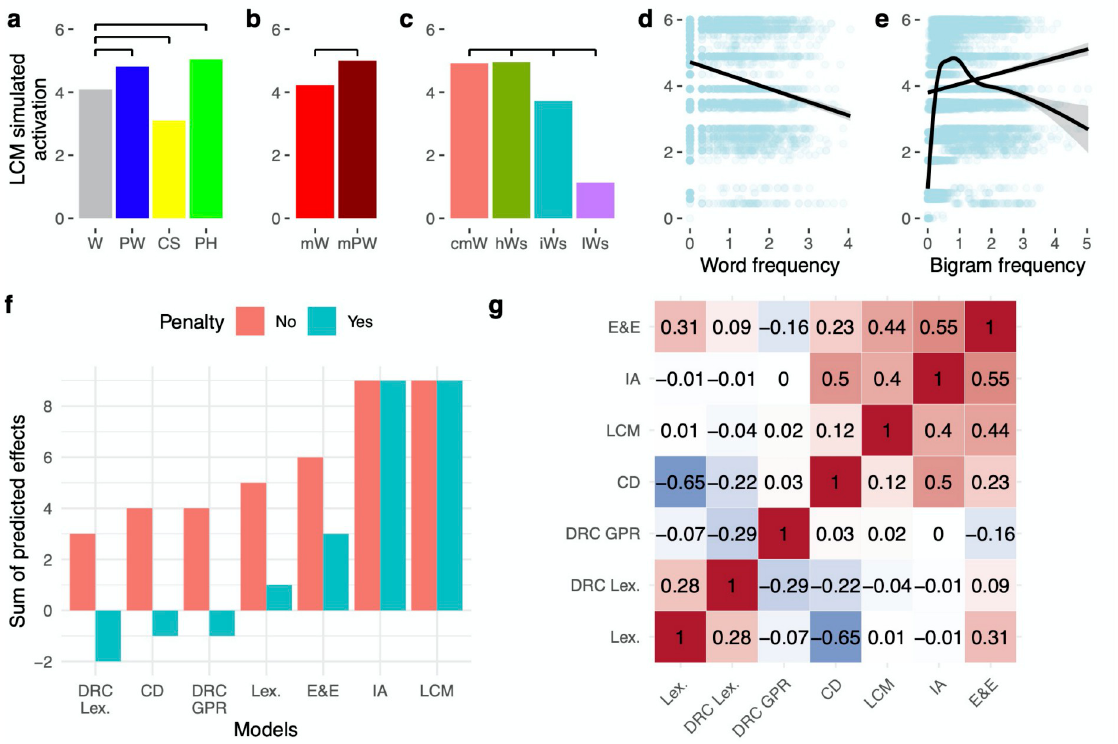
Fig 2. Evaluation based on simulations: LCM and model comparisons based on simulations of lvOT benchmark effects from the fMRI literature. Model comparisons involve the lexicon model, local combination detector model (CD), effort and engagement model (E&E), the interactive account model (IA; for implementations and detailed simulations see S1 Text ), and the cognitive Dual Route model, specifically its orthographic lexicon (DRC Lex.) and its grapheme to phoneme conversion route (DRC GPR; for detailed simulations see S1 Fig ). Simulated lvOT activation (in arbitrary units: min = 0; max = 6) for all groups of letter strings is presented using bar graphs depicting their respective mean activation. In addition, horizontal black bars indicate significant differences of the simulation results between letter string categories, as derived from linear models (Bonferroni corrected). LCM simulated lvOT activation is presented, from left to right, (a) for words (W), pseudowords (PW), consonant strings (CS), pseudohomophones (PH), (b) words and pseudowords matched on number of syllables, number of Coltheart’s orthographic neighbors, frequency of the highest frequency neighbor, initial bigram frequency, final bigram frequency, and summated bigram frequency (mW, mPW), and (c) the word similarity effect comparing words (cmW: comparative matched words) to non-words with high word similarity (matched on quadrigram frequency; hWS), to non-words with intermediate word similarity (matched on bigram frequency; iWS), and, to non-words with low word similarity (lWS). In addition, (d) the effect of log. transformed word frequency (for all words and pseudowords as tested in [14]) and (e) log. transformed bigram frequency are presented as scatter plots with a linear regression line. Note that for bigram frequency, also a non-linear regression line is shown. In (d) and (e), each dot represents one letter string, the more saturated the blue gets, the more letter strings are included. See text for more detailed description of the replicated benchmark effects including the specific stimulus sets used and references to the original studies. (f) Qualitative model comparisons showing the sum of correctly simulated stimulus differences (orange bars) and all correct minus all incorrectly simulated effects excluding null effects (cyan bars). The LCM and the IA were able to correctly simulate all contrasts. (g) Correlation matrix of all model parameters included in the model comparison, showing that simulations of the non-linear models, i.e., LCM, E&E, and IA, were substantially correlated (all r’s >